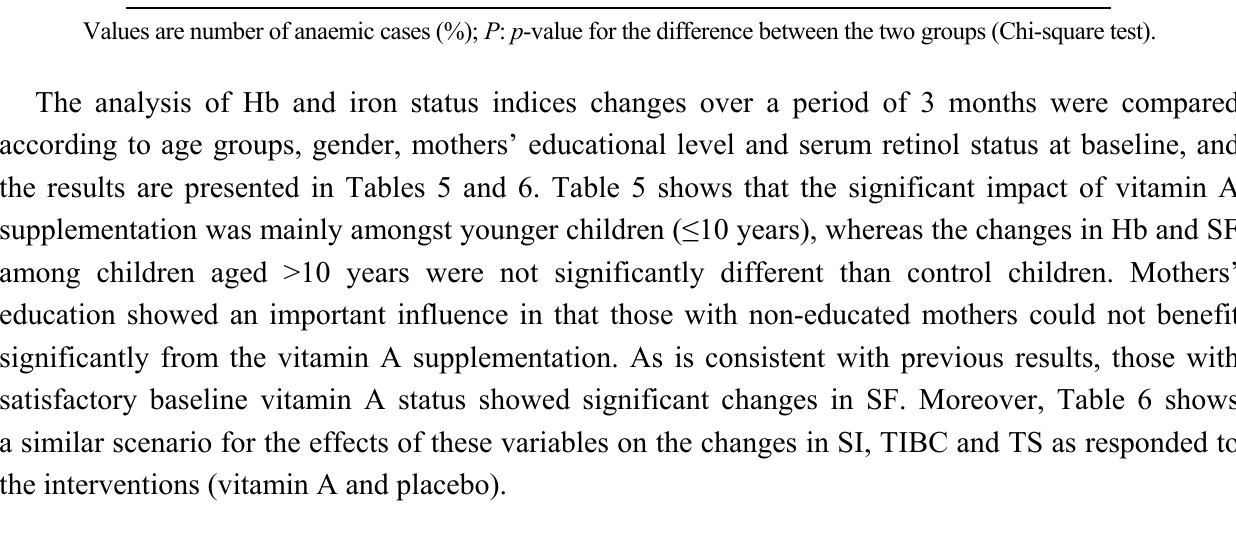
Table 5. Mean changes in Hb and SF among schoolchildren in the vitamin A and placebo groups according to selected